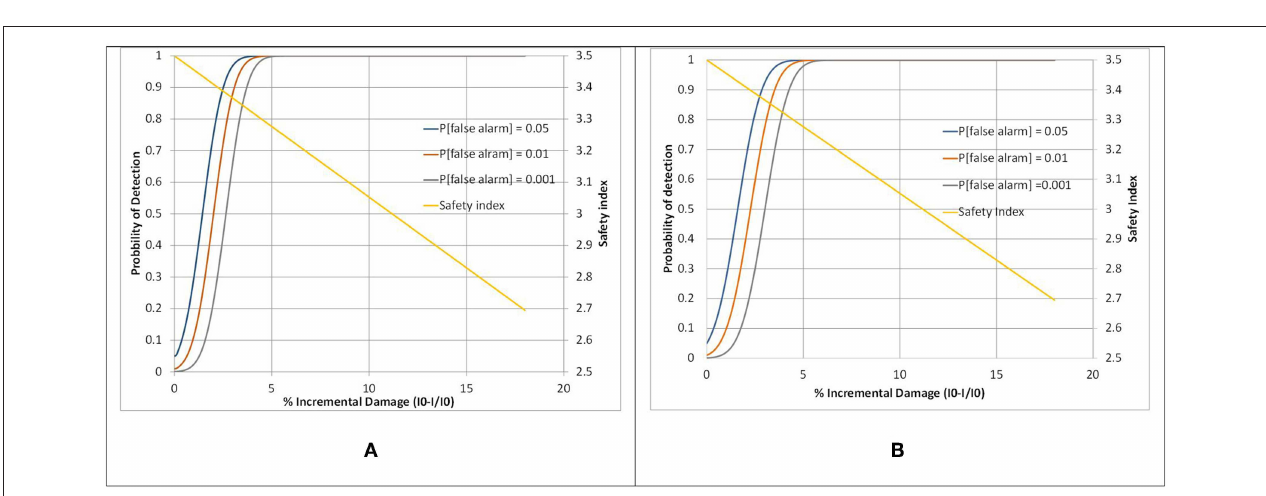
FIGURE 11 | Probability of detection and safety index as a function of damage level and probability of false alarms for damage located at (A) 0.17L and (B) 0.65L (using